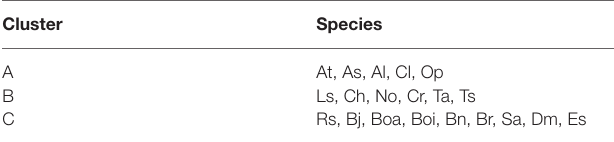
TABLE 2 | Clustering result using K-means. Cluster